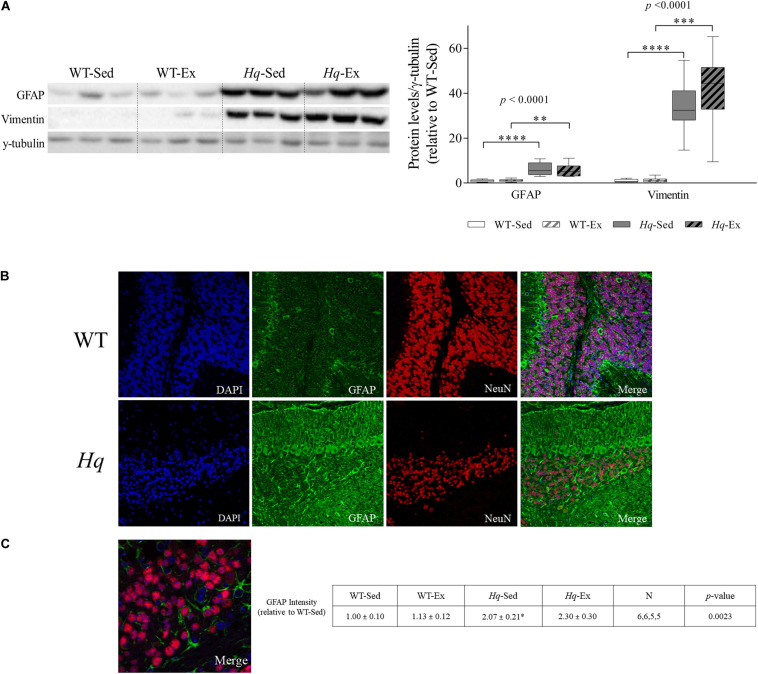
Astrogliosis markers. (A) Western blot analysis of glial fibrillary acidic protein (GFAP) and vimentin in cerebellum homogenates of wild-type sedentary (WT-Sed, n = 12) and exercise-trained (WT-Ex, n = 11) mice, and of Hq sedentary (Hq-Sed, n = 11) and exercise-trained (Hq-Ex, n = 10) mice. Densitometry analysis: protein levels were normalized to γ-tubulin levels; data (median, interquartile range, and min and max values) are expressed relative to levels in the WT-Sed group. Significant p-values for the group effect (Kruskal-Wallis test) are shown above the corresponding bars. Symbols for significant differences in post hoc pairwise comparisons: ∗p < 0.05; ∗∗p < 0.01; ∗∗∗p < 0.001; *⁣*⁣**p < 0.0001 for Hq-Sed vs. WT-Sed, and Hq-Ex vs. WT-Ex. (B) Immunodetection of GFAP (green) and NeuN (red), cell nuclei (blue) and merged images in representative sedentary WT and Hq mice (10×). Inmunofluorescence semi-quantitation was performed in 6 WT-Sed, 6 WT-Ex, 5 Hq-Sed and 5 Hq-Ex animals (1 section per mouse). Only representative WT-Sed and Hq-Sed images are shown for simplicity purposes, due to absence of training-induced effect. (C) Higher magnification images showing direct interaction between GFAP-positive astrocytes (green) and granule neurons (red) in a representative sedentary Hq mouse (63×).